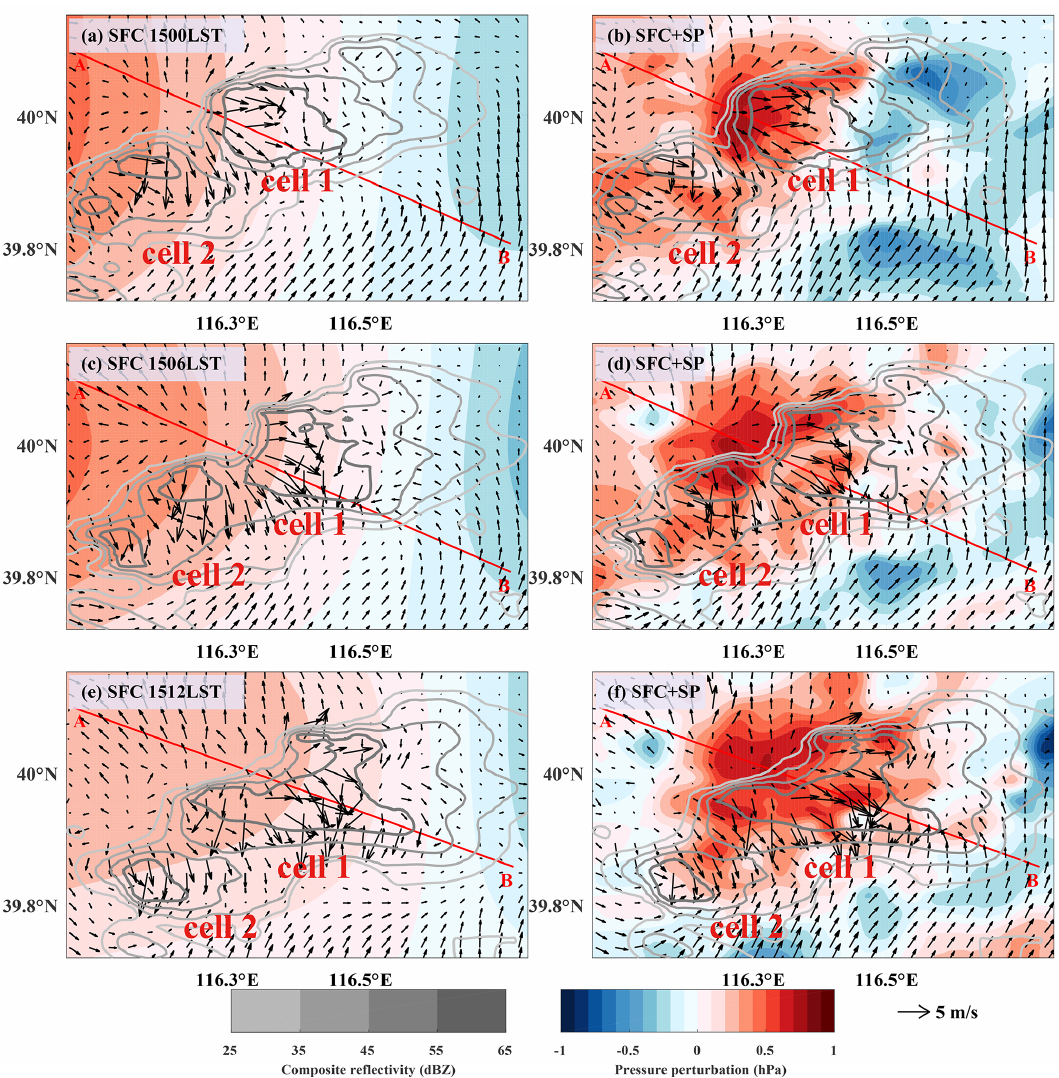
Figure 14. Surface pressure perturbation analyses (shaded) from the experiment SFC (a, c, e) and SFC + SP (b, d, f) overlaid by VDRAS wind field at 150m (thick black arrows) and column maximum radar reflectivity (contours). The valid time is 15:00LST for the top row, 15:06LST for the middle row and 15:12LST for the bottom